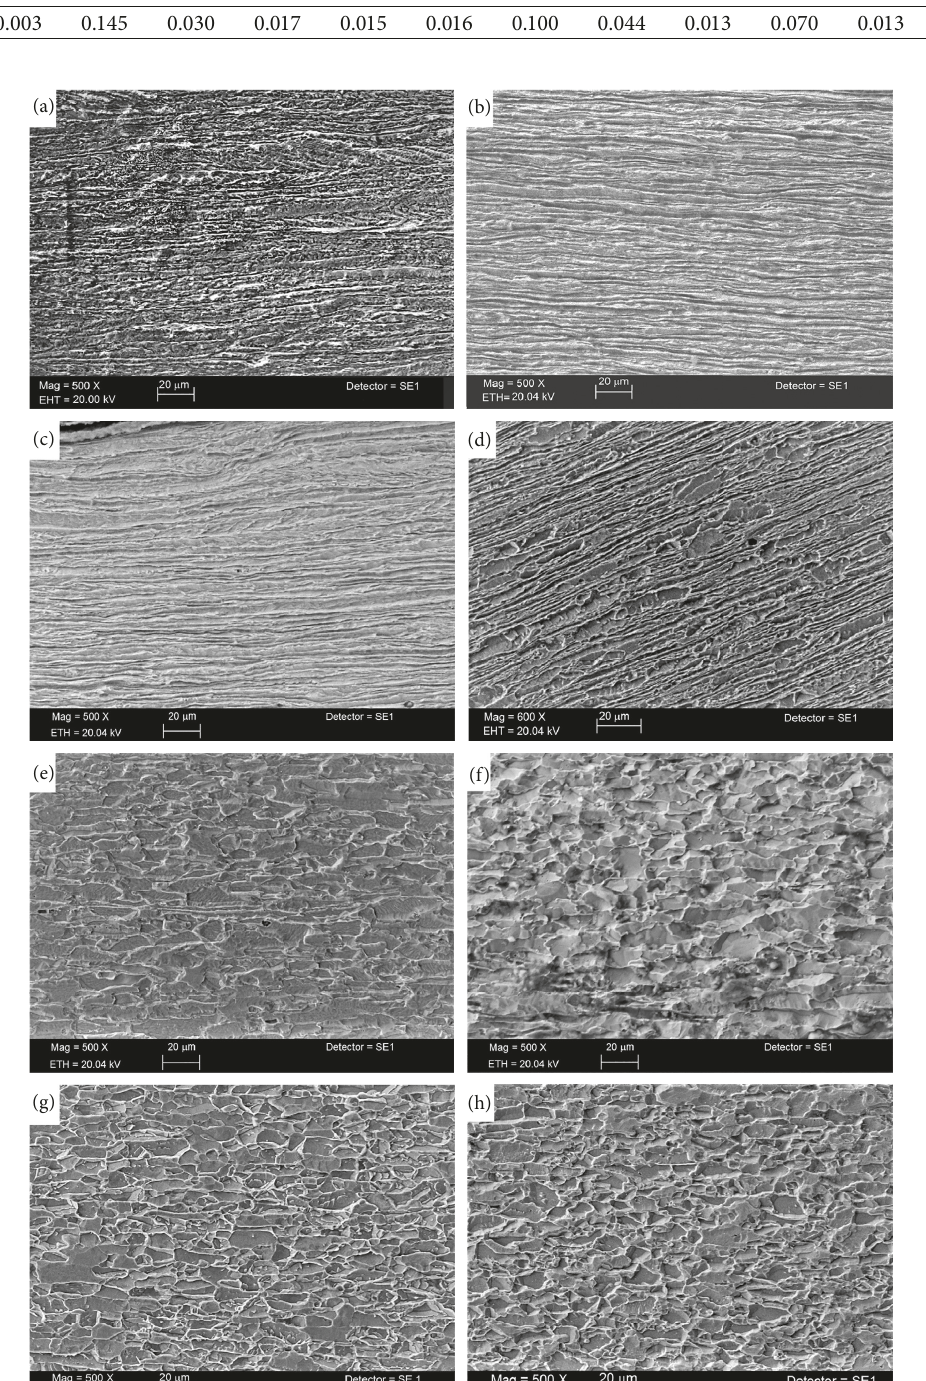
Figure 1: Scanning electron micrographs (SEM images) showing the effect of recrystallisation treatment at 780 ° C on the microstructural evolution of cold-rolled IF steel at different times. (a) 0s, (b) 60 s, (c) 120s, (d) 180s, (e) 240s, (f) 300s, (g) 360s, and (h) 420 s.